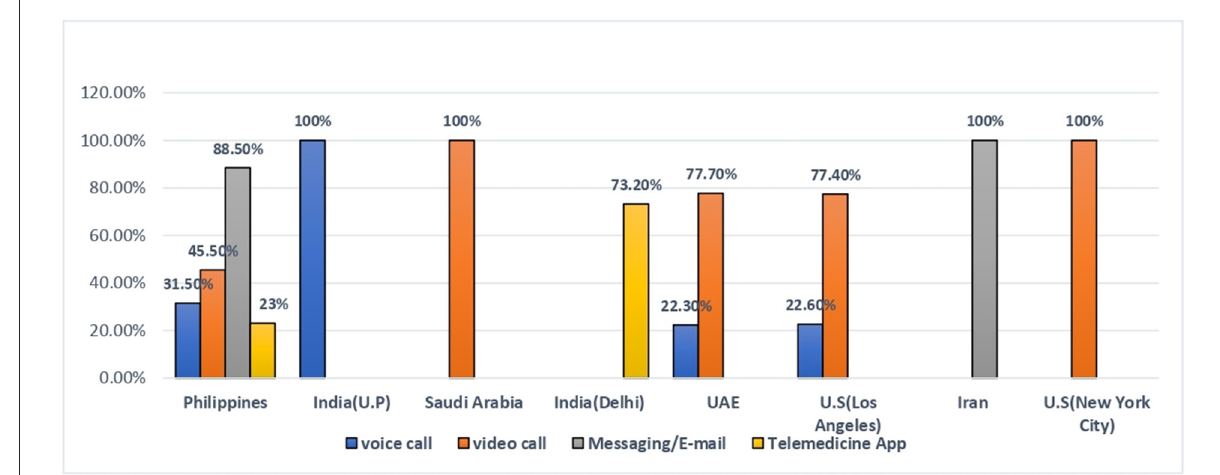
FIGURE4 Tools for telemedicine.